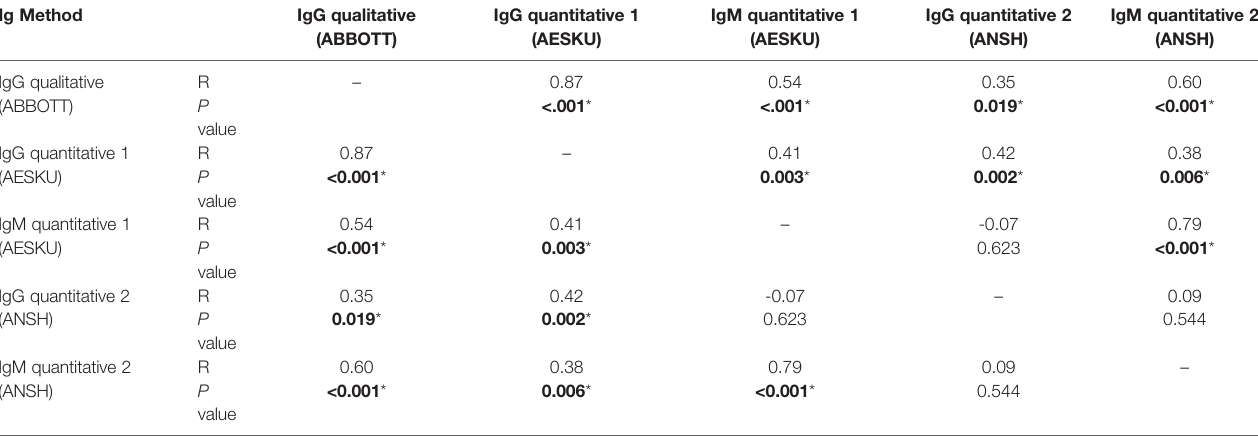
TABLE 2 | Pearson correlation testing between qualitative IgG indices and quantitative IgG and IgM titers using different methods (pooled data). Ig Method